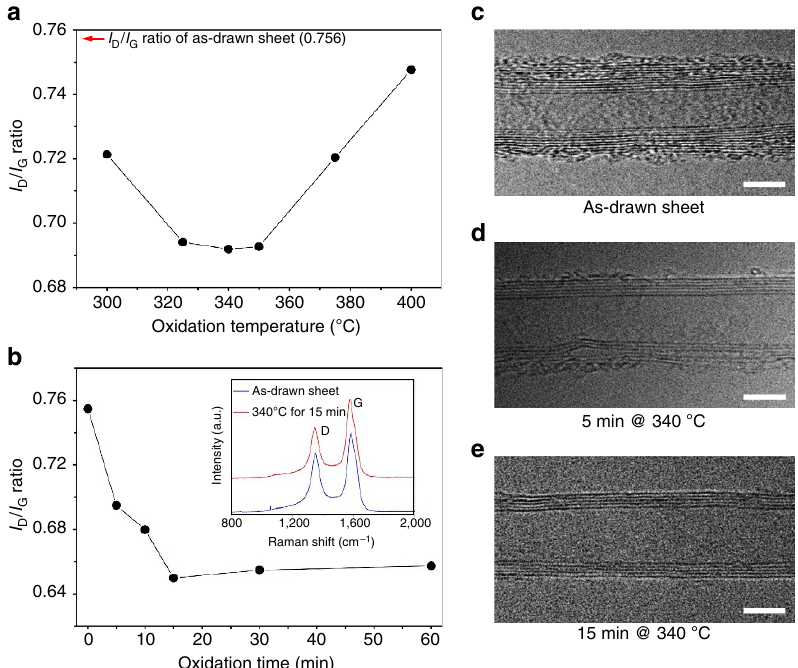
Figure 2 | The effects of thermal oxidation temperature and time. ( a ) The dependence of Raman I D / I G ratio on oxidation temperature for a 5-min anneal of CNTaerogel sheets in ambient air. ( b ) The dependence of the I D / I G ratio for CNTaerogel sheets on oxidation time in ambient air at 340 (cid:2) C. The inset shows the Raman spectra for an as-drawn CNTsheet and for a CNTsheet that has been thermally oxidized in air for 15min at 340 (cid:2) C. ( c – e ) High-resolution transmission electron microscope (HR-TEM) images of ( c ) as-drawn, ( d ) 5-min oxidized, and ( e ) 15-min oxidized CNT aerogel sheets (all scale bars,